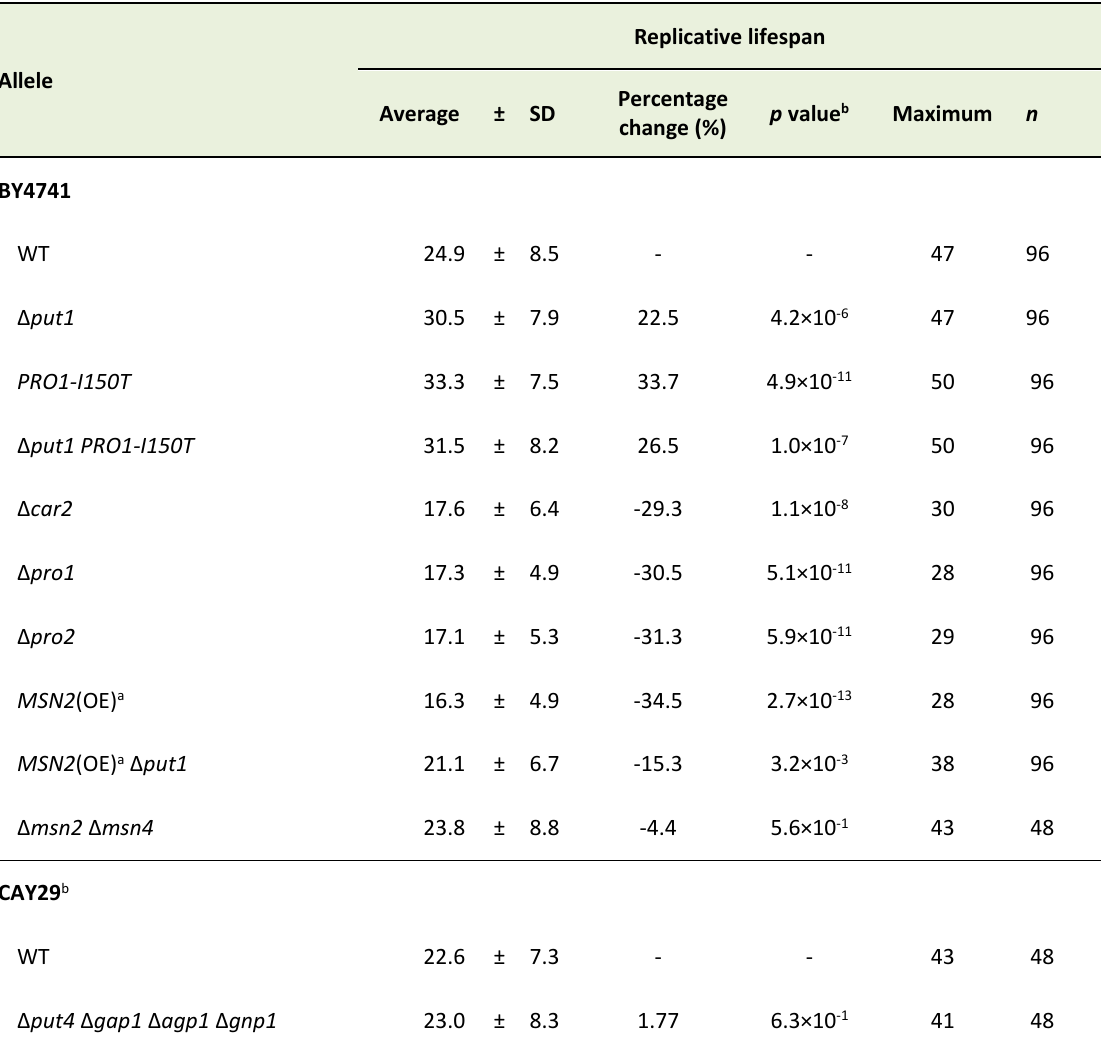
TABLE 1. Replicative lifespan of yeast mutants involved in proline metabolism.